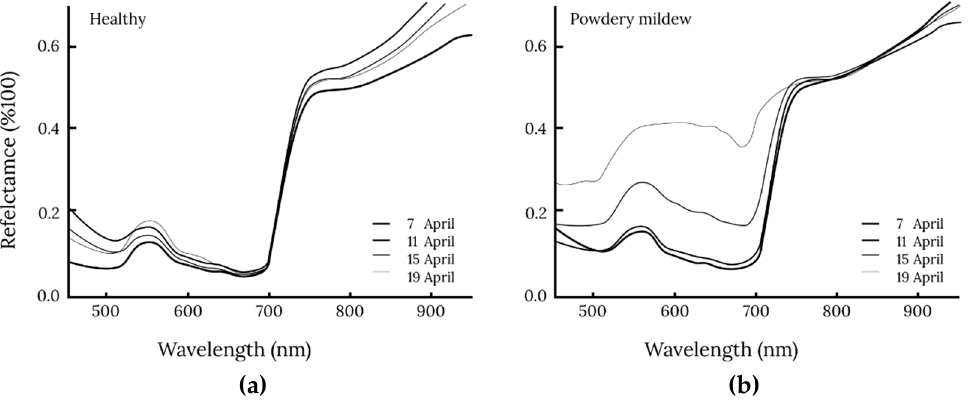
Figure 2. Spectral reflectance of ( a ) healthy cucumber leaves and ( b ) leaves inoculated with Sphaerotheca fuliginea (powdery mildew) [38].